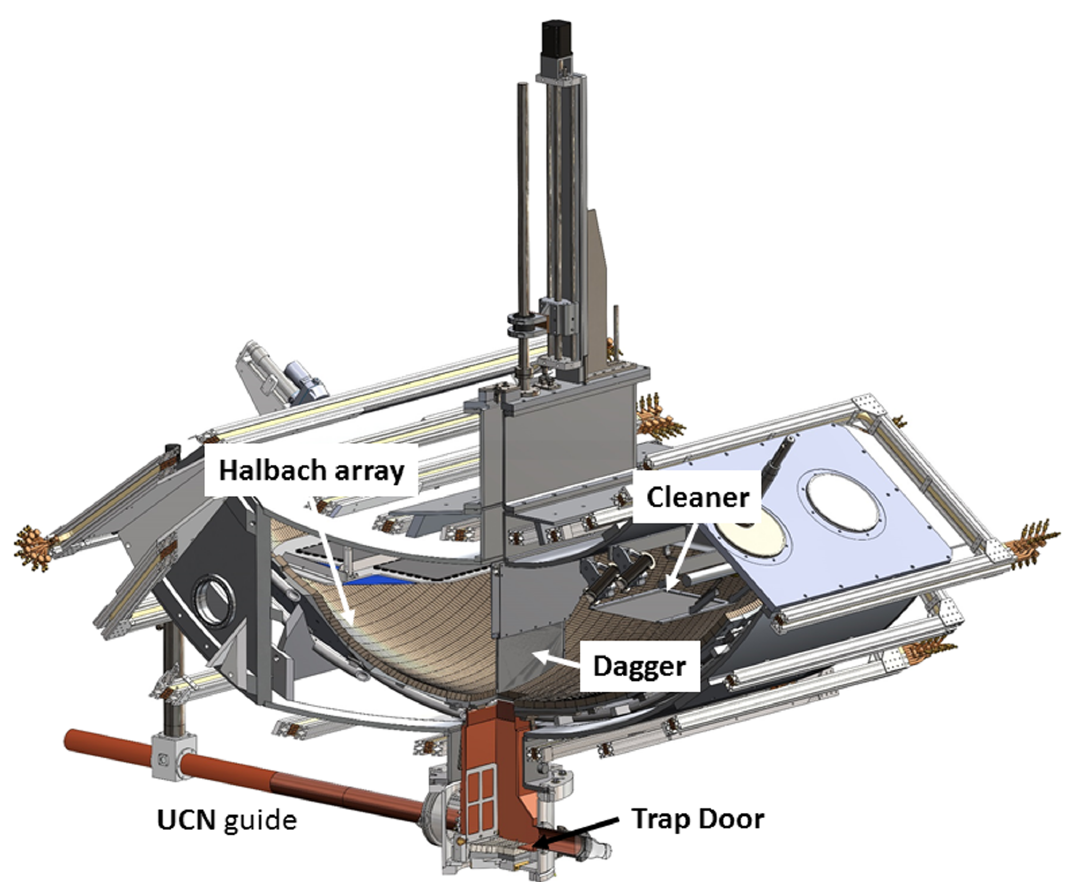
Figure 6. A rendering of the UCN τ apparatus [45,46] showing the Halbach array installed on the walls FIG. 1. Cross sectional view showing the detector, the actuator, and the UCN of the UCN storage vessel, the polyethylene sheet used to clean the initial neutron velocity spectrum, trap. The locations of the dagger, cleaner, and trap door are shown. The dagger and the insertable in situ neutron scintillation detector (dagger). To fill the vessel, polarized neutrons is in its lowest (counting) position and the trap door is in its loading (lowered) are admitted via the trap door at the bottom. position.